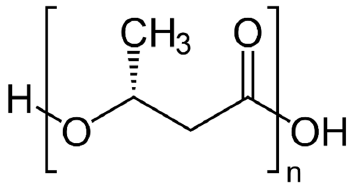
Figure 1. General structure of poly(3-R-hydroxyalkanoates) (PHA).